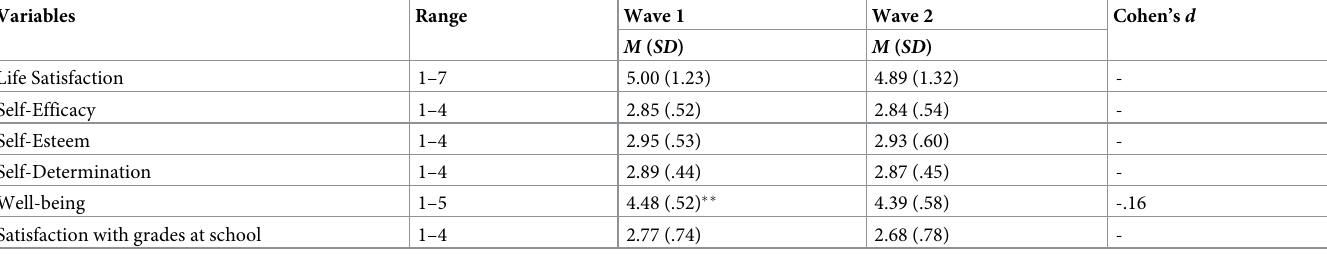
Table 1. Wave 1 and wave 2 sample mean levels (and standard deviations) of all observed variables.